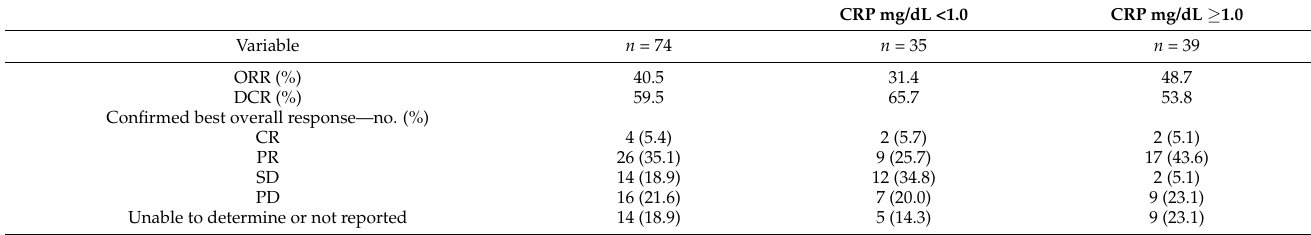
Table 3. Confirmed best objective response for 74 patients treated with ilipimumab and nivolumab.